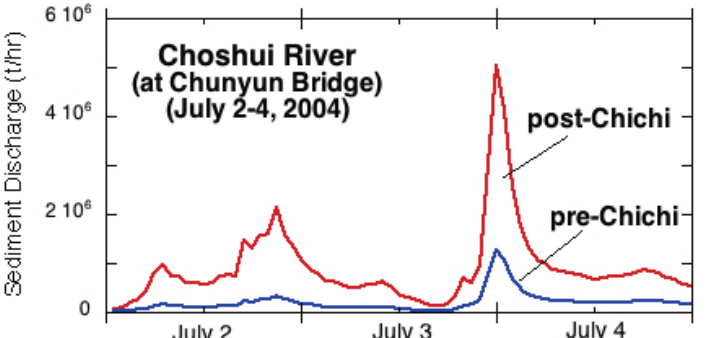
Fig. 7 Calculated sediment discharge past the Chunyun Bridge, July 2-4, 2004. Post-Chichi calculated loads are based on rating curves (2) and (3), whereas the pre-Chichi load was calculated assuming no earthquake, i.e. rating curve (1). The difference between the pre- and post-Chichi curves indicates the amount of discharged sediment generated by the Chichi earthquake, in this case, ~50